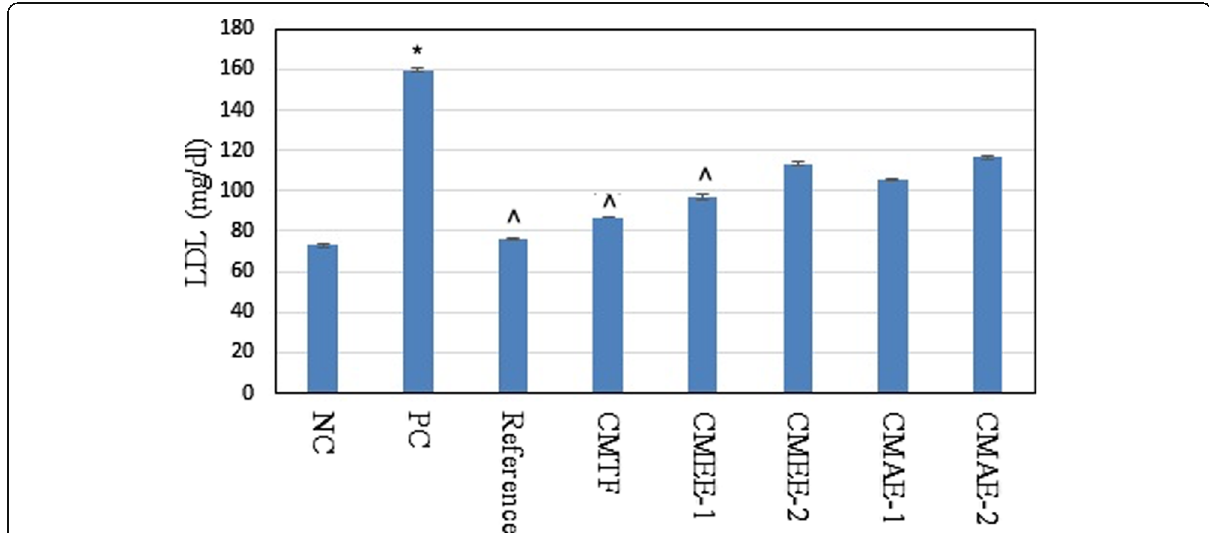
Fig. 3 Effect of C. melo fraction and extracts on the LDL level of animals. Values are expressed as mean ± standard error of mean ( n = 6), significantly different at * P < 0.05, vs the normal control group; △ P < 0.05, vs the diabetic control group analyzed by one-way ANOVA followed by Tukey ’ s multiple comparison test. CMTF, Cucumis melo toluene fraction (ethanolic extract); CMEE 1, Cucumis melo ethanolic extract (400 mg/kg); CMEE 2, Cucumis melo ethanolic extract (200 mg/kg); CMAE, Cucumis melo aqueous extract (400 mg/kg); CMAE, Cucumis melo